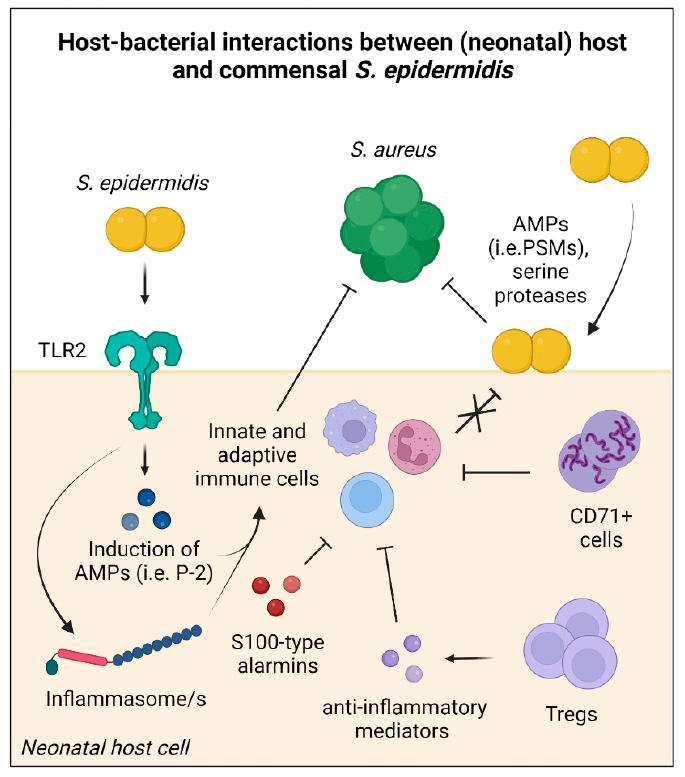
Figure 1. Summary of potential mechanisms underlying the establishment of neonatal tolerance to commensal S. epidermidis and its contribution to neonatal host defense. Antimicrobial peptides (AMPs), Phenol-soluble modulins (PSMs), Peforin-2 (P2), Toll-like receptor (TLR), Regulatory T cells (Tregs). Created with BioRender.com.